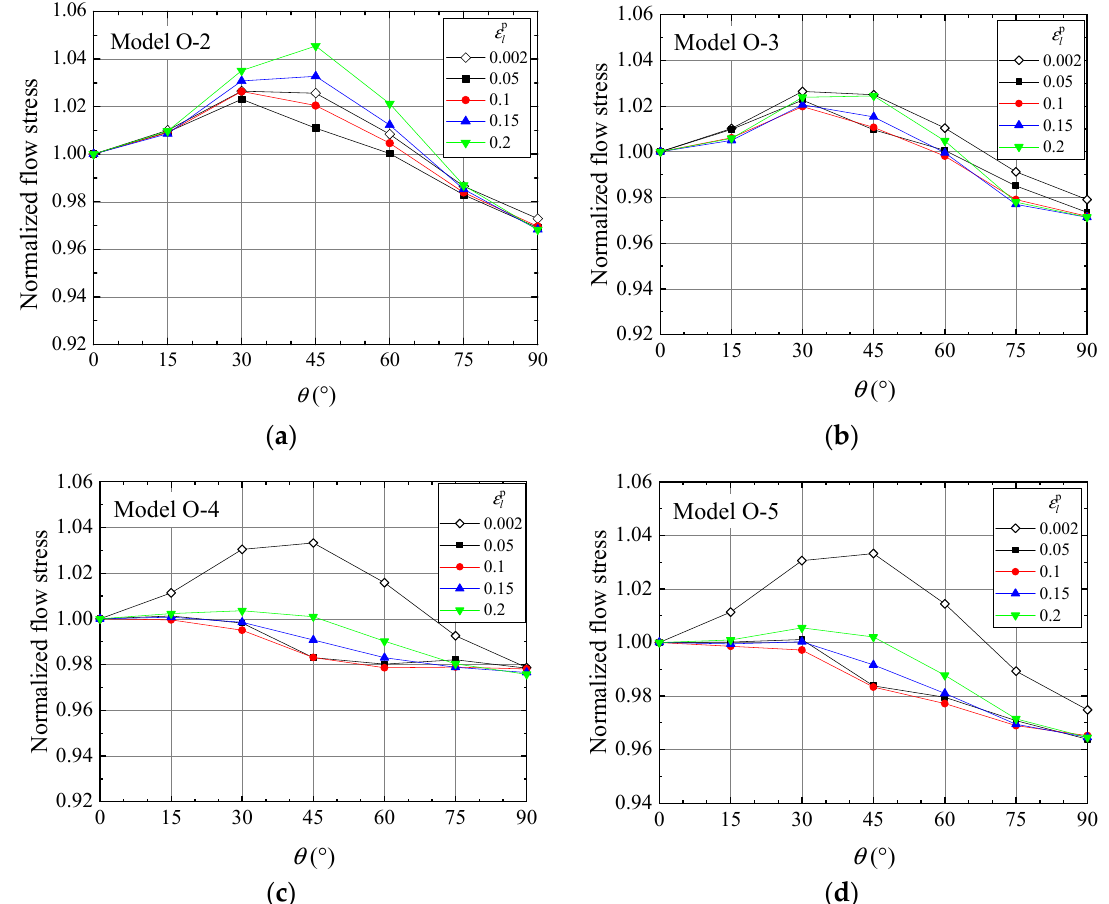
Figure 6. Crystal plasticity prediction of normalized flow stress for ( a ) model O-2, ( b ) model O-3, ( c ) model O-4, and ( d ) model O-5.